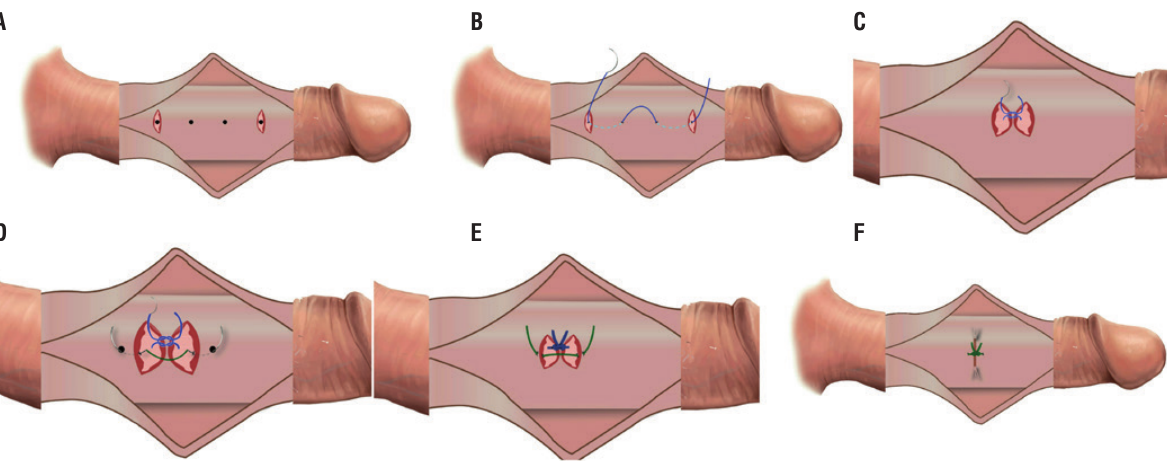
Figure 1 - Diagrammatic steps of CPI technique 1A) Two transverse incisions through outer layer of tunica albuginea at first and last dots. 1B and C) Ethibond suture passing through interior edges of the incisions and plicating the intermediate 2 dots. 1D) vicryl suture passing through outer free edges of the incisions. 1E) Tightening and ligation of the Ethibond. 1F) Closure of outer edges over ethibond suture